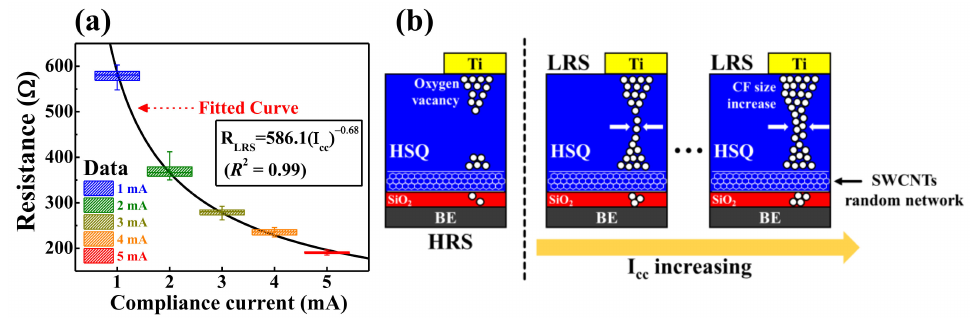
Figure 8. HSQ memristor w/ the embedded SWCNT random network: ( a ) Dependence of the average R LRS values according to the magnitude of I cc and ( b ) simple schematics of the conductive filament formation in the RS layer of the SWCNT random network embedded in the HSQ thin-film